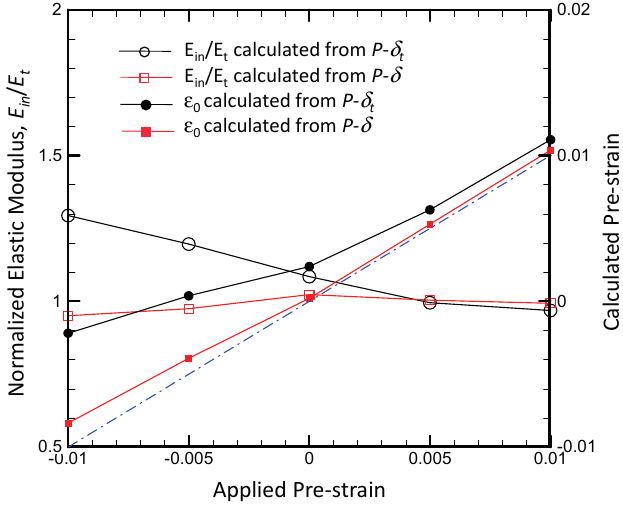
and the pre-strain in /E in t